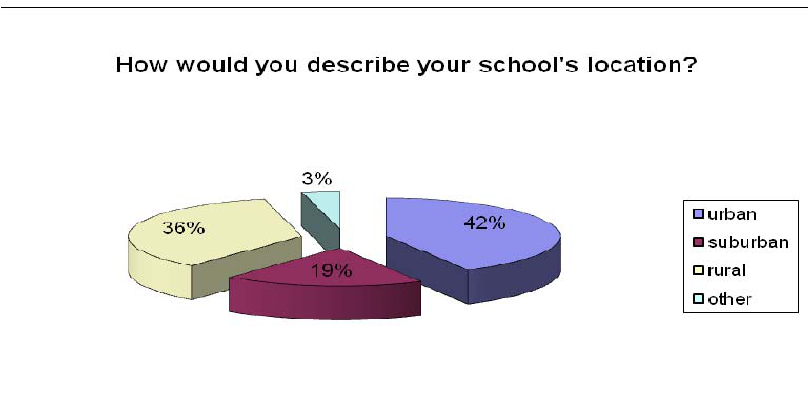
Figure 1 . Location of